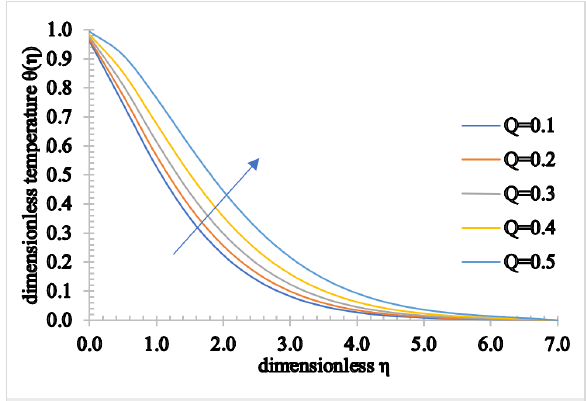
Figure 15: The temperature profile for increasing values of Q .